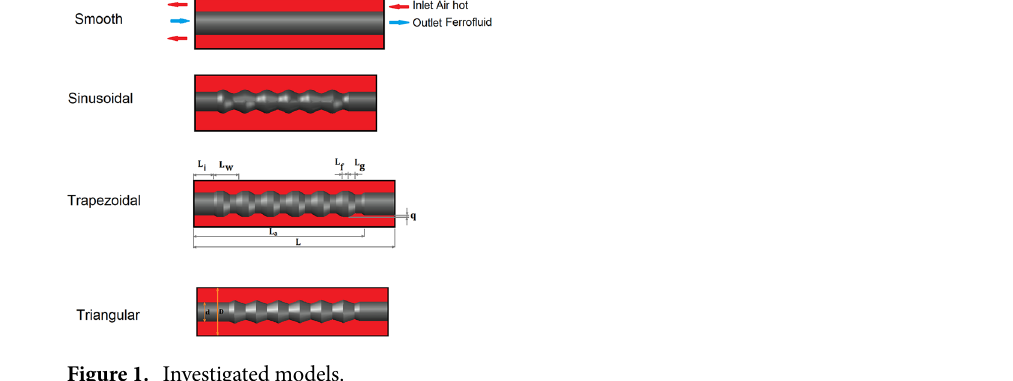
Figure 1. Investigated